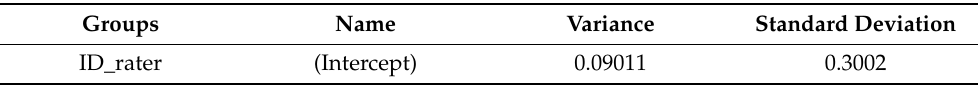
Table 4. Mixed-effects model for perceived accentedness in German: random-effects factor.